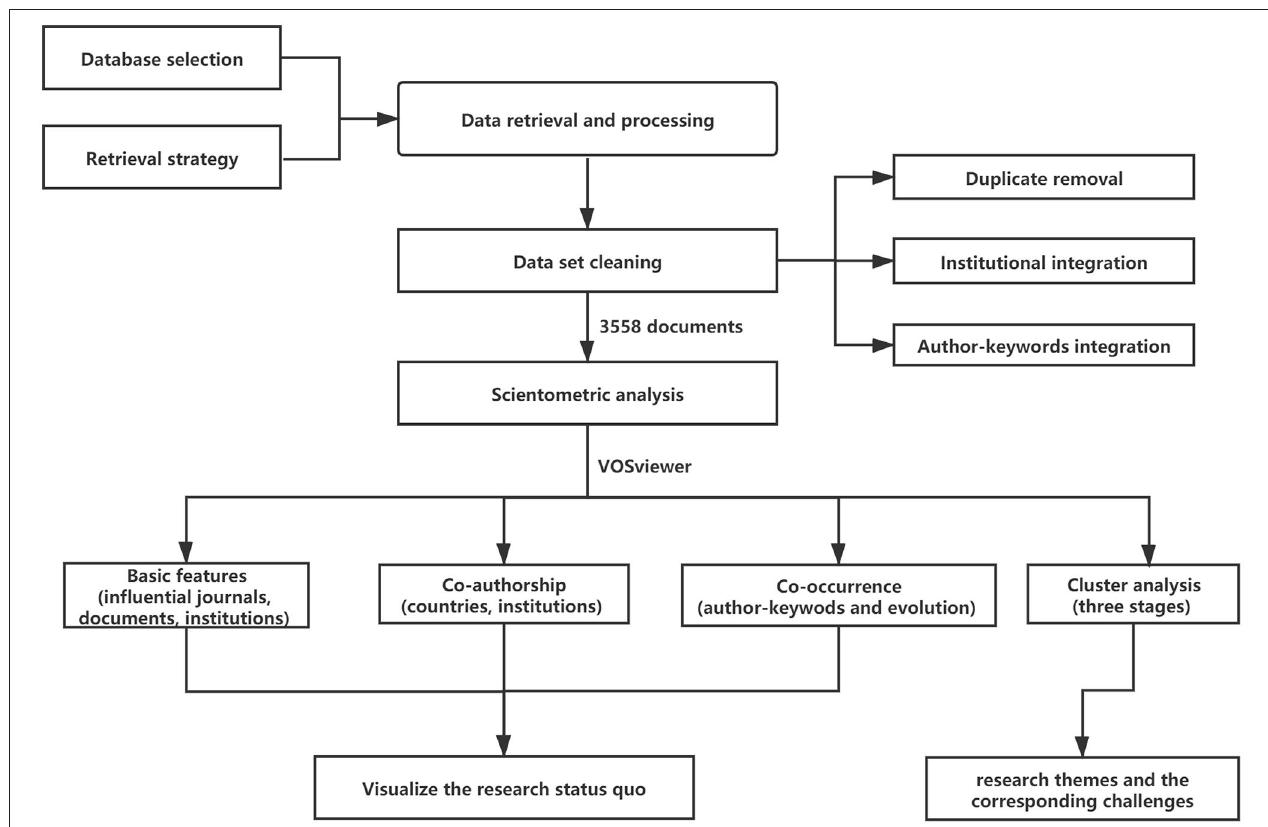
FIGURE 1 | Outline of research design.